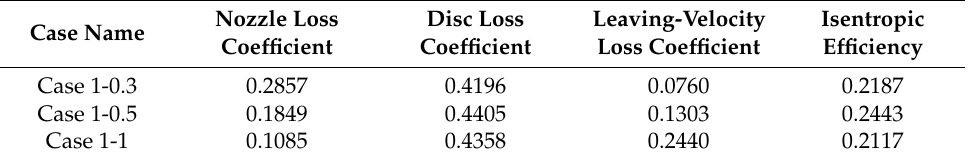
Table 5. Coefficients of component energy loss for one-to-one Tesla turbine cases.